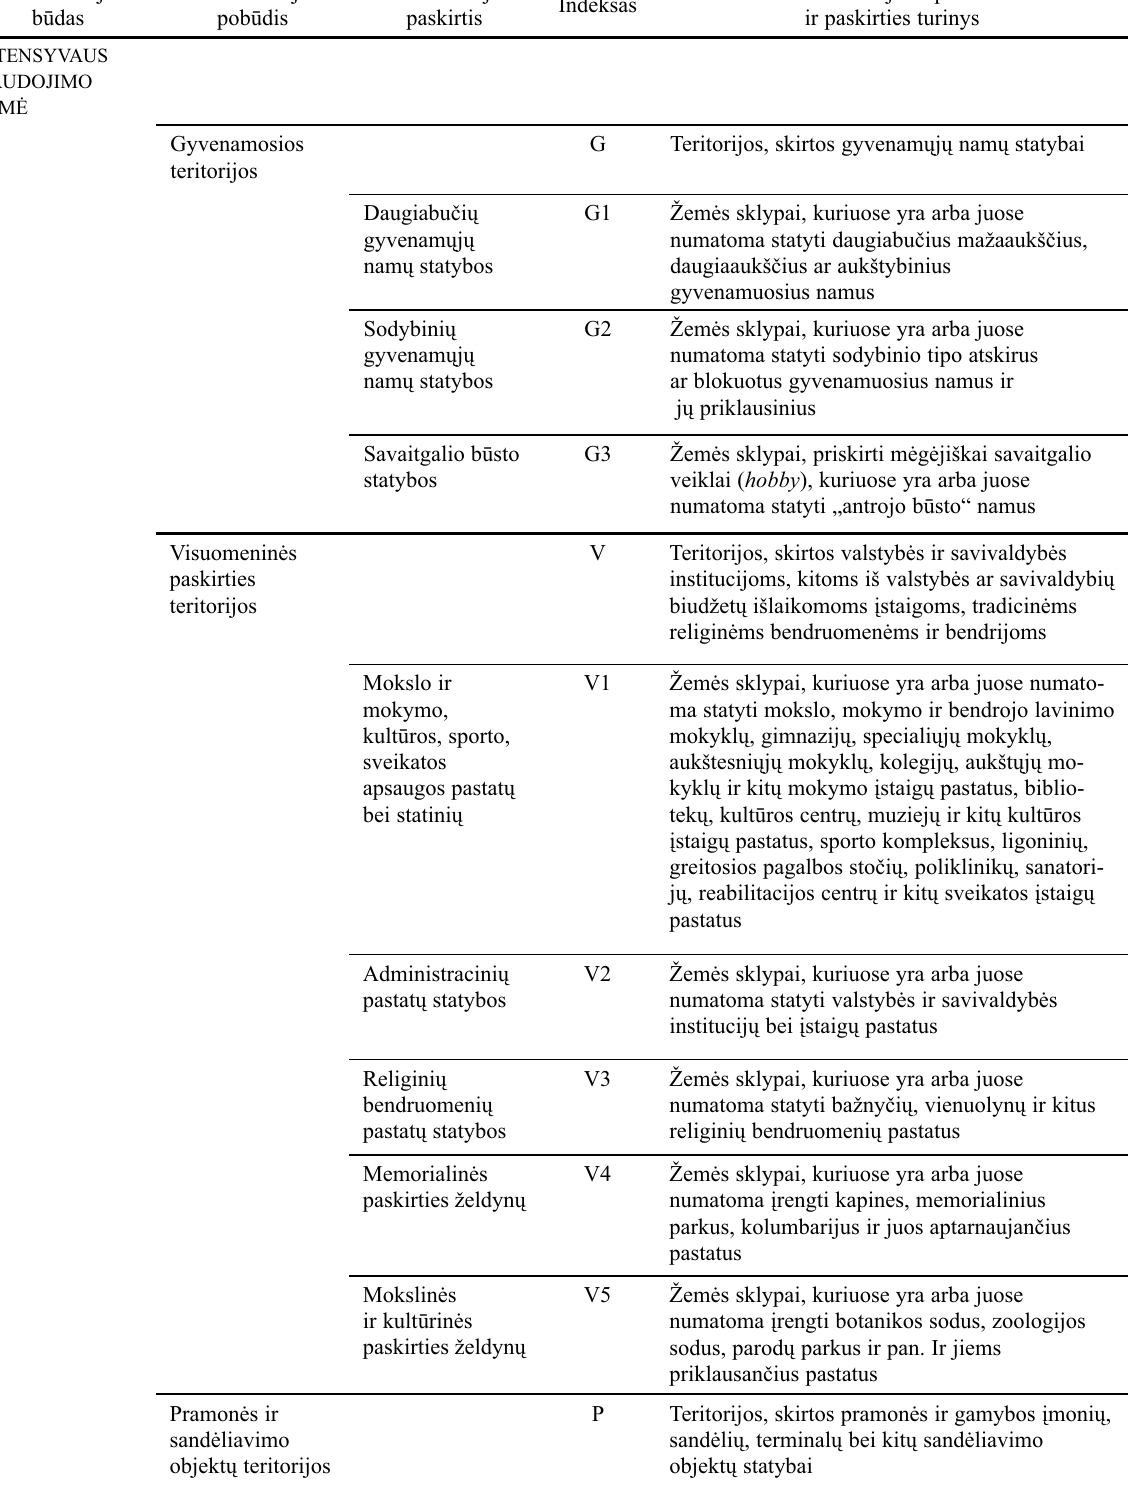
Table 2. Specification of land use in towns and townships (draft changes) Žemės